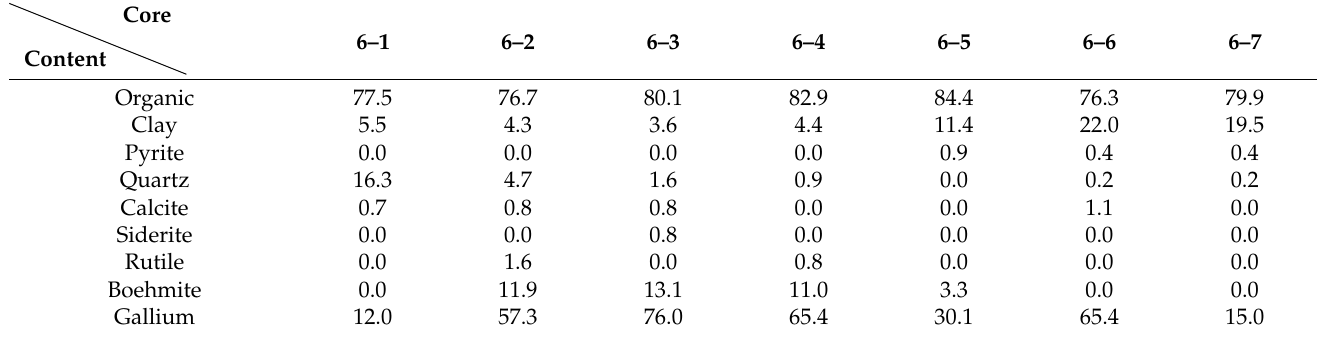
Figure 2. Geological column of No. 6 coal and the sampled core locations and numbers. Table 1. Weight contents of measured components in cores from No. 6 coal (edited from [5]). The unit for organic and mineral contents is weight percentage, and the unit for gallium is ppm.